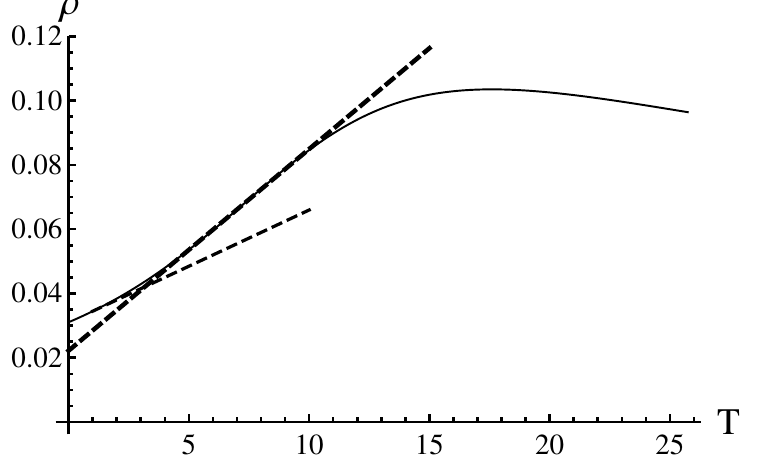
Figure 2 . Plot of resistivity versus low temperature for z = 4 = 3 ; (cid:18) = 0 ; Q 2 = 1000 and (cid:11) = 10, The longer straight dashed line represents